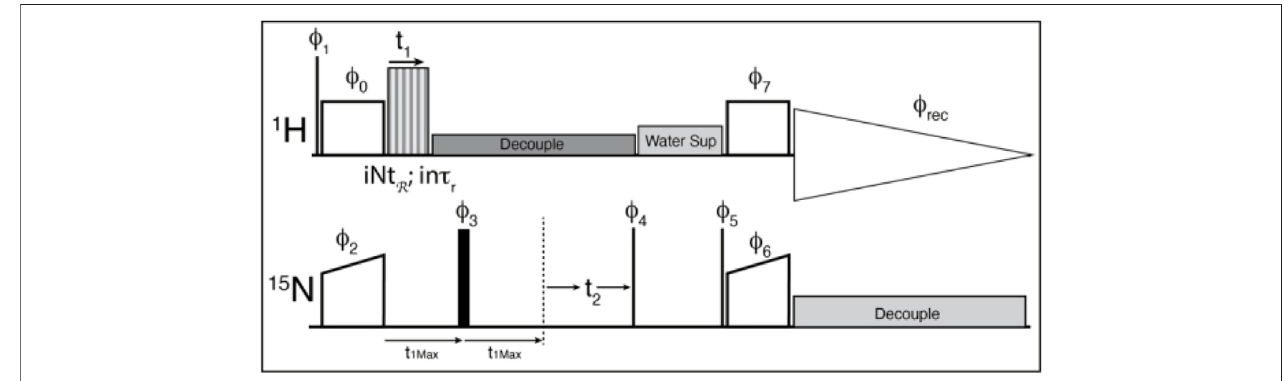
FIGURE 4 | The pulse sequence used for the experiments. Thin lines represent 90 ° pulses, and thick lines represent 180 ° pulses, boxes indicate cross polarization spinlockpulses.Thesequenceismodi fi edfromtheusualsolid-stateNMRCP-HSQCbytheadditionofanechoperiod,andtheapplicationoftherecouplingperiod. ϕ